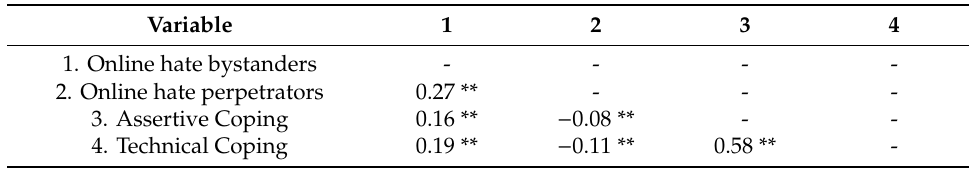
Table 1. Bivariate correlations between online hate bystanders, online hate perpetrators, assertive coping, and technical coping.